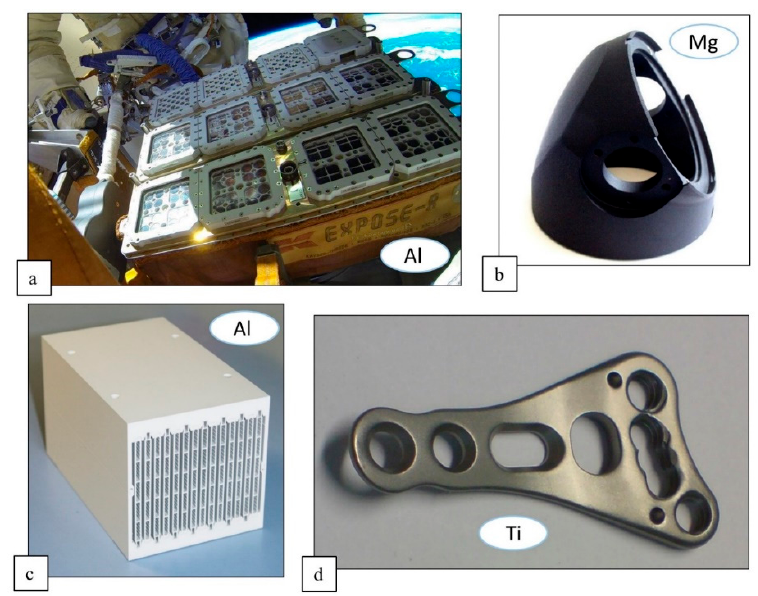
Figure 14. Application examples for PEO coatings (commercial name PCO ®® ) on different substrates: setup for astrobiological experiments during the expose program at the ISS ( a ), a heat sink ( b ), optical die-cast component ( c ), and a plate for osteosynthesis ( d ), products of INNOVENT e.V. [ 35].